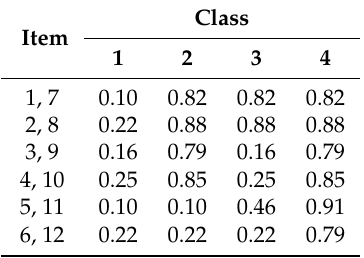
Table 1. Data illustration dichotomous data: true item response probabilities p ic .